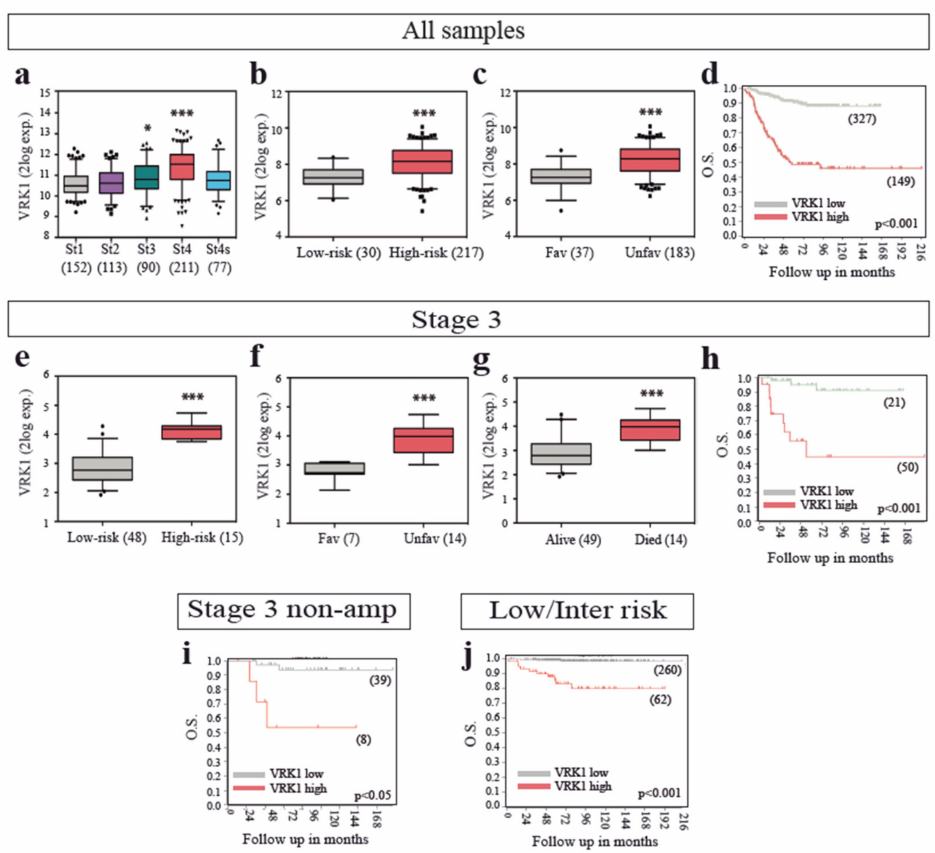
Figure 1. VRK1 mRNA expression correlates with neuroblastoma (NB) progression in patient tumor samples. ( a – c ) VRK1 expression in patient tumor samples of all stages separated by the International Neuroblastoma Staging System (INSS) stage a, the International Neuroblastoma Risk Group Staging System (INRGSS) risk b or histology c. GSE62564 and GSE3446 datasets used; ( d ) Kaplan curve showing overall survival probability from patients stratified according to VRK1 expression (GSE62564); ( e – g ) stage 3 patient tumor samples separated by risk ( e ) histology ( f ) or outcome ( g ). GSE62564 and GSE3446 datasets used; ( h – j ) Kaplan curve showing overall survival probability from stage 3 patients ( h ) stage 3 MYCN nonamplified patients ( i ) or low / intermediate risk patients ( j ) stratified according to VRK1 expression (GSE62564). Number of samples shown in brackets. *: p < 0.05; ***: p <